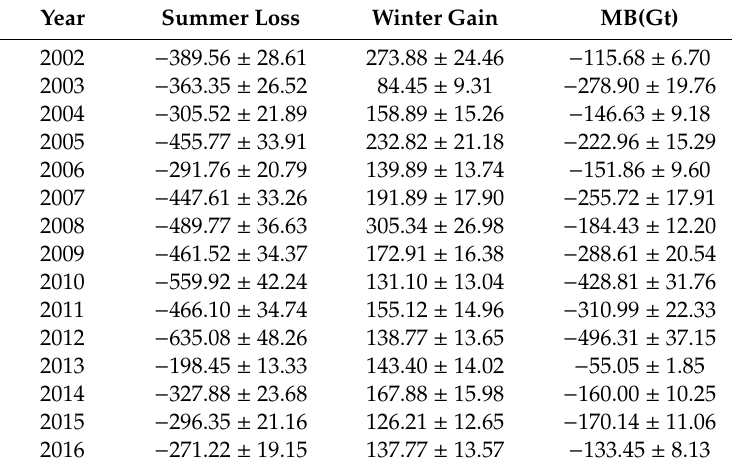
Table 1. Mass changes from the GRACE during 2002 to